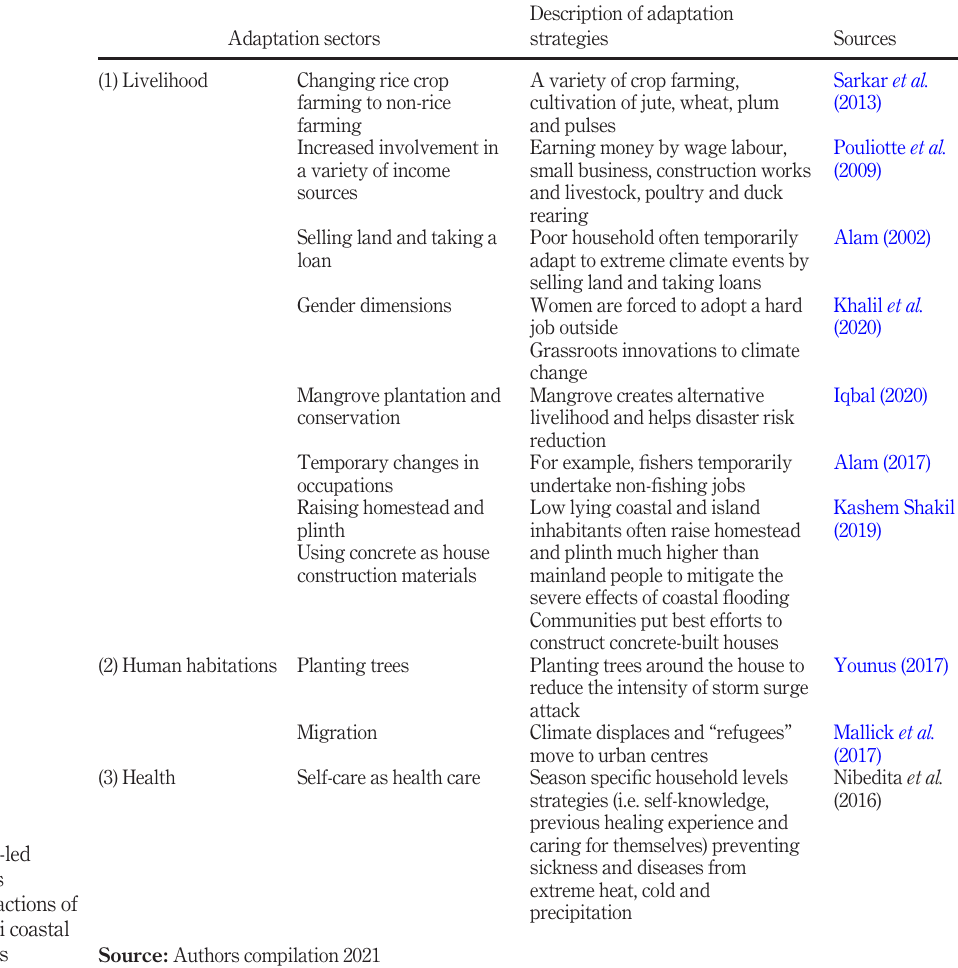
Table 2. Community-led autonomous adaptation actions